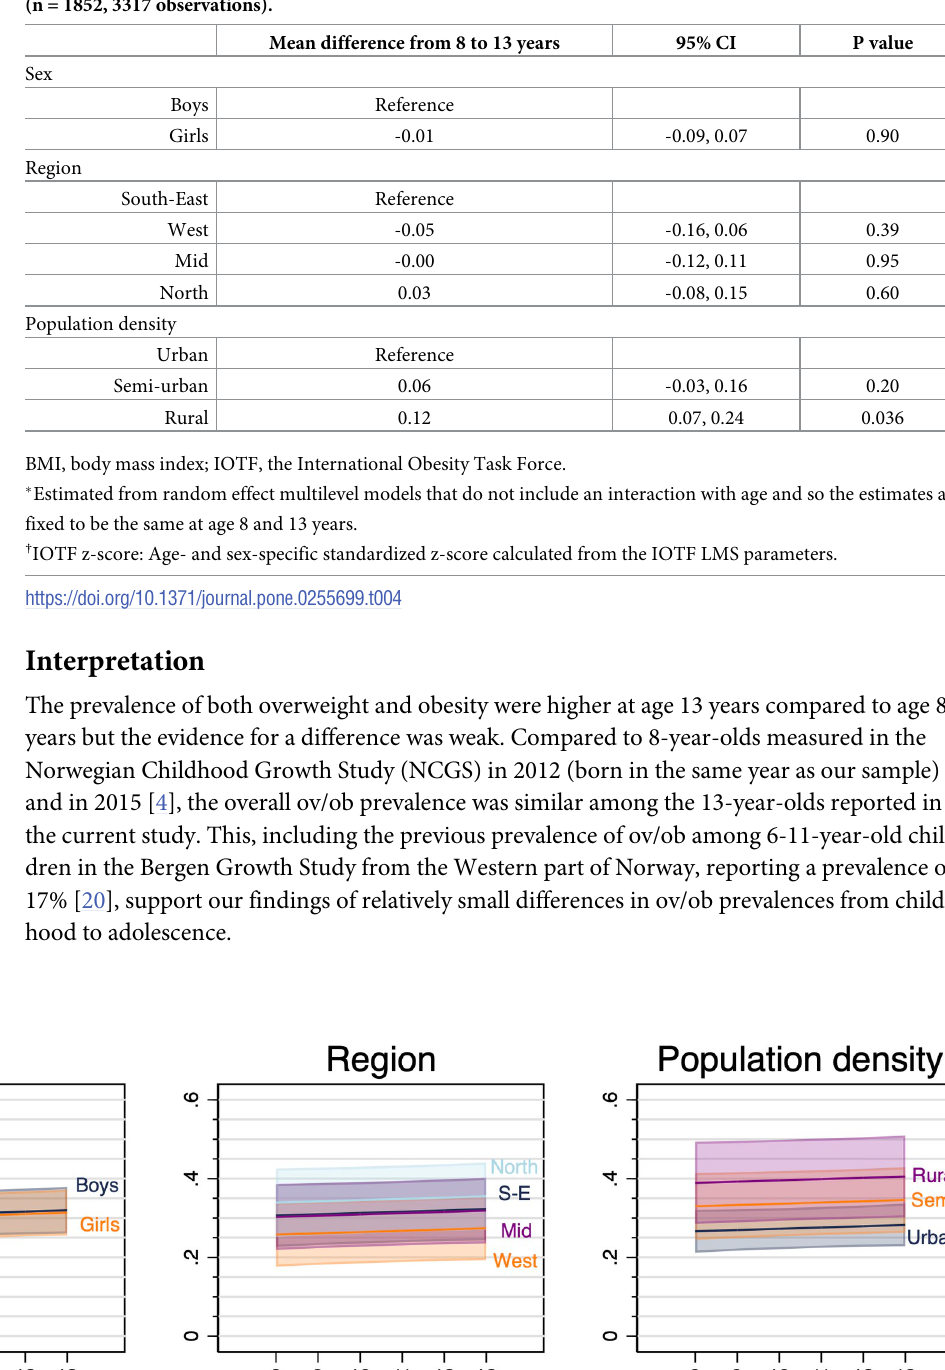
Table 4. Associations � of sex, region, and population density with mean BMI IOTF z-score † from 8 to 13 years (n = 1852, 3317 observations). Mean difference from 8 to 13 years 95% CI P value Sex Boys Reference